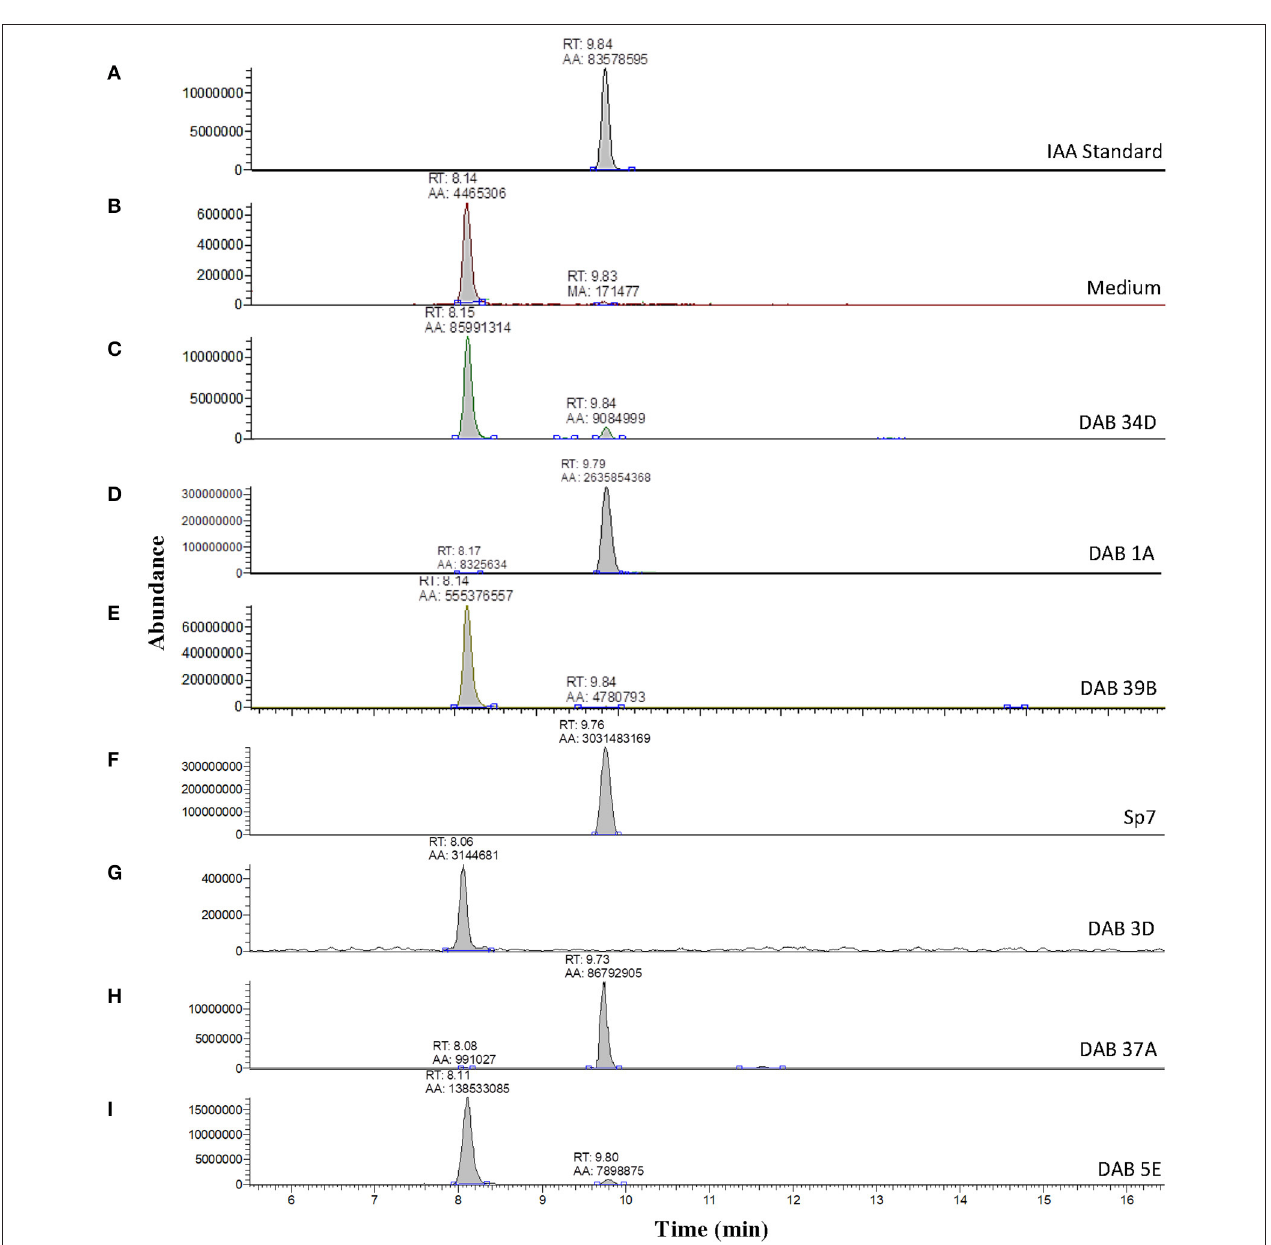
FIGURE 3 | Validation of IAA production in DABs by mass spectrometry. LC-MS extracted positive ionization ion chromatograms at m/z 176.06 to m/z 176.08 ([M + H] of IAA). RT, retention time; AA, automatic area under peak; MA, manual area under peak. (A) Chromatogram (EIC) from an injection of 5 ng/ µ L of free IAA suspended in 100% acetonitrile showing a retention time of 9.84min. (B) EIC showing a low background signal at the RT of free IAA in the LB medium sample. A second signal is detected at a retention time of 8.14min in the LB medium sample. (C) EIC from the LB medium with brown-type Vogesella strain, DAB 34D. (D) EIC from the LB medium with pink-type Microbacterium strain, DAB 1A. (E) EIC from the LB medium with brown-type Aeromonas strain, DAB 39B. (F) EIC from the LB medium with pink-type Azospirillum strain, Sp7. (G) EIC from the LB medium with no color change Bacillus strain, DAB 3D. (H) EIC from the LB medium with pink-type Azospirillum strain, DAB 37A. (I) EIC from the LB medium with pink-type Herbaspirillum strain, DAB 5E. The scales on the Y-axis are automatically adjusted to show all the peaks in each of the chromatograms. Note the different scale on the chromatogram in (B) to show the lower quantity peaks.